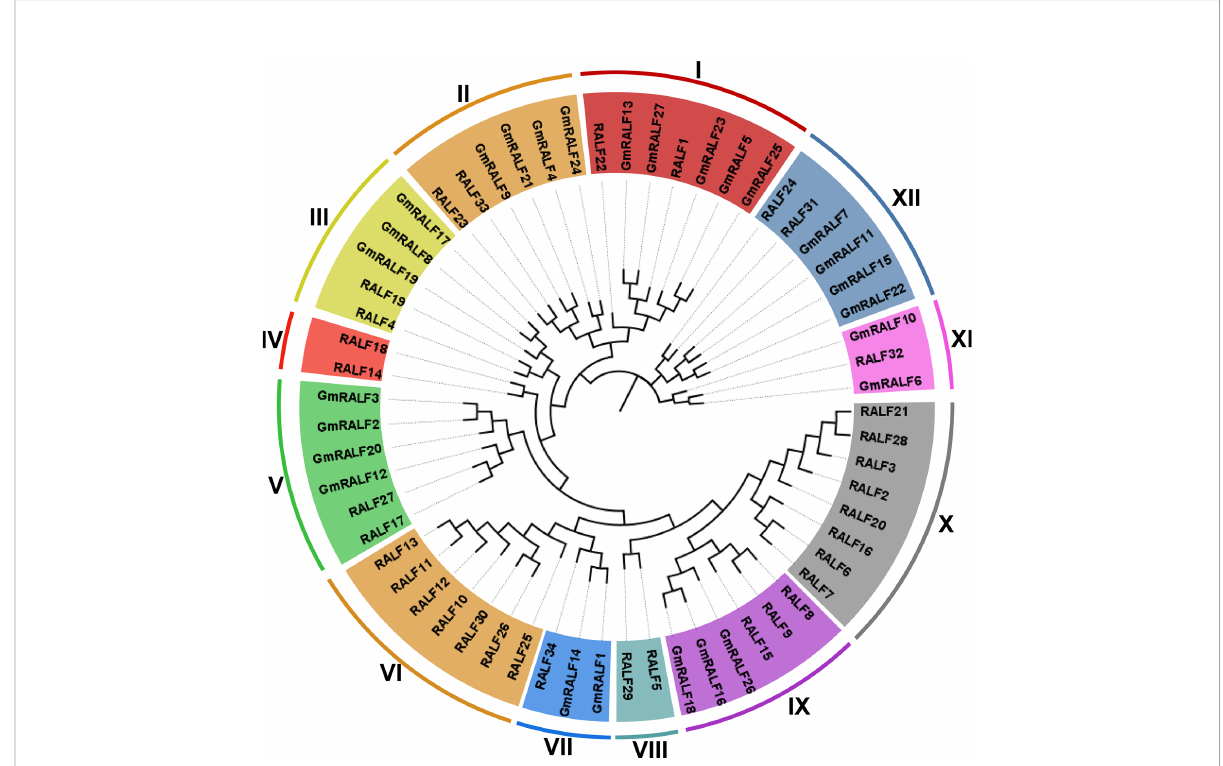
FIGURE 1 Phylogenetic tree of RALF proteins in soybean and Arabidopsis . Full-length protein sequences were aligned using Muscle. The phylogenetic tree was constructed employing the UPGMA method with 1,000 bootstrap values in MEGA 7.0 software, and was optimized with the Figtree v1.4.3. The clades were marked with different